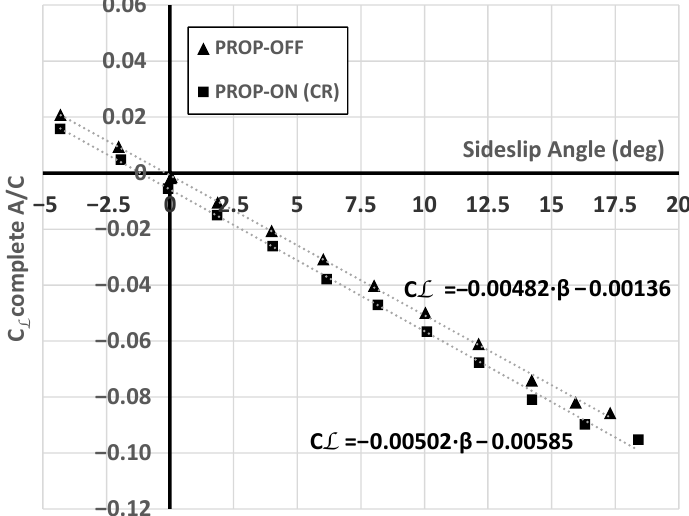
Figure 21. Indirect propeller slipstream effects on complete aircraft rolling moment coefficient, experimental results, Re = 315,000, 8750 RPM (CR), X CG at LE MAC, α = 0 deg. This aerodynamic behavior is qualitatively explained in the chart of Figure 22.